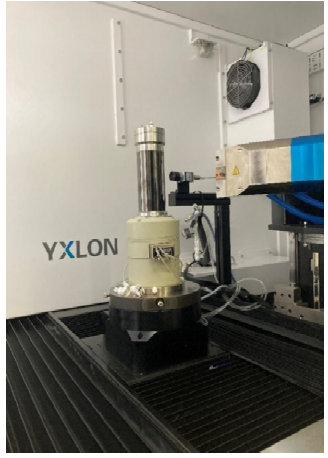
Figure 3. Deben CT5000.